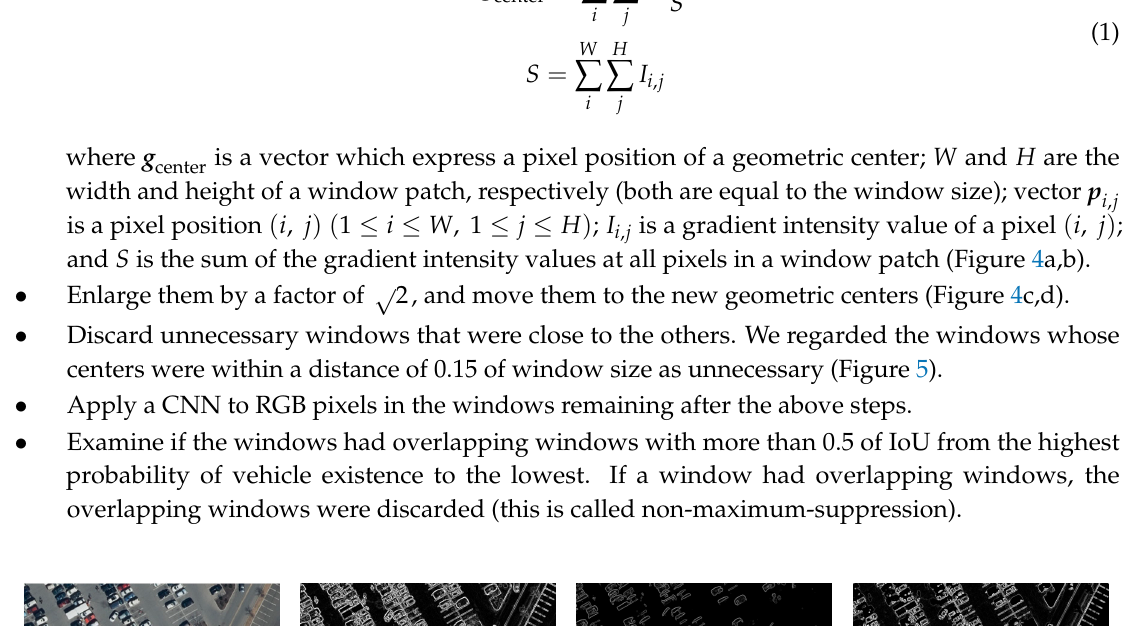
Figure 4. An example of a sliding window move. ( a ) An initial window; ( b ) moved to its geometric center; ( c ) enlarged; ( d ) moved to its new geometric center.